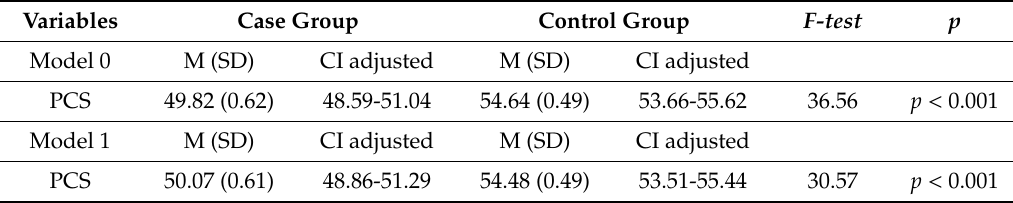
Table 4. Mean di ff erences (analysis of covariance (ANCOVA)) in the mental component summary adjusted for age (Model 0) and adjusted for age + BMI (Model